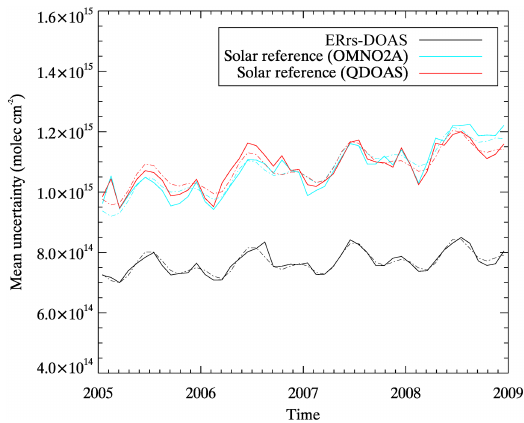
Figure 12. The distribution of the deviations of OMI NO 2 SCDs from the box-mean (2 ◦ × 2 ◦ ) values in the equatorial Pacific region (100–120 ◦ W, 10 ◦ N–10 ◦ S) for June 2005. The SCDs were derived by DOAS fitting OMI spectra using an Earth radiance reference. The red line shows the fitted Gaussian function.